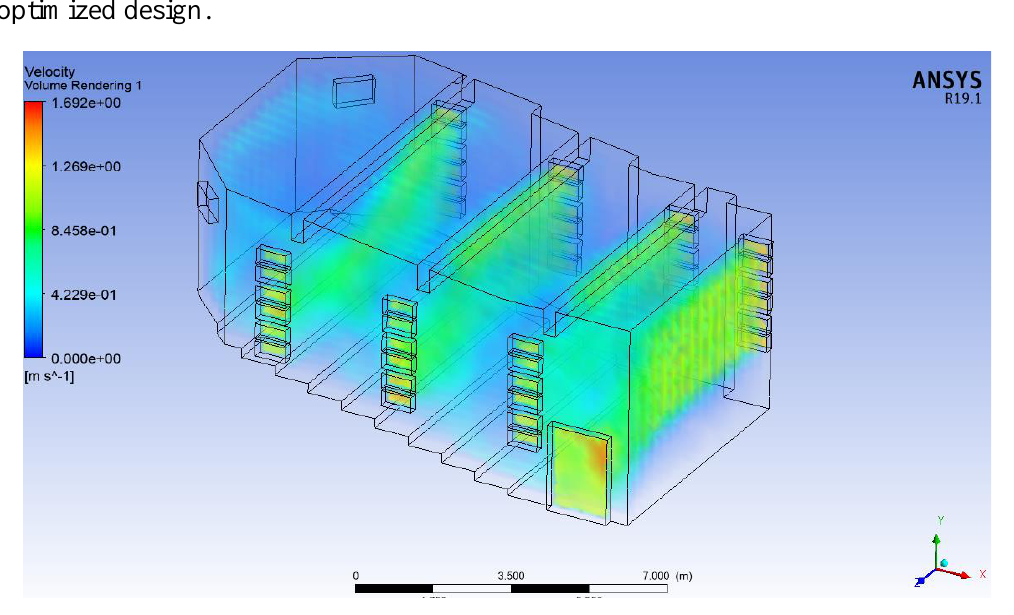
Figure 11. Optimized Design Velocity